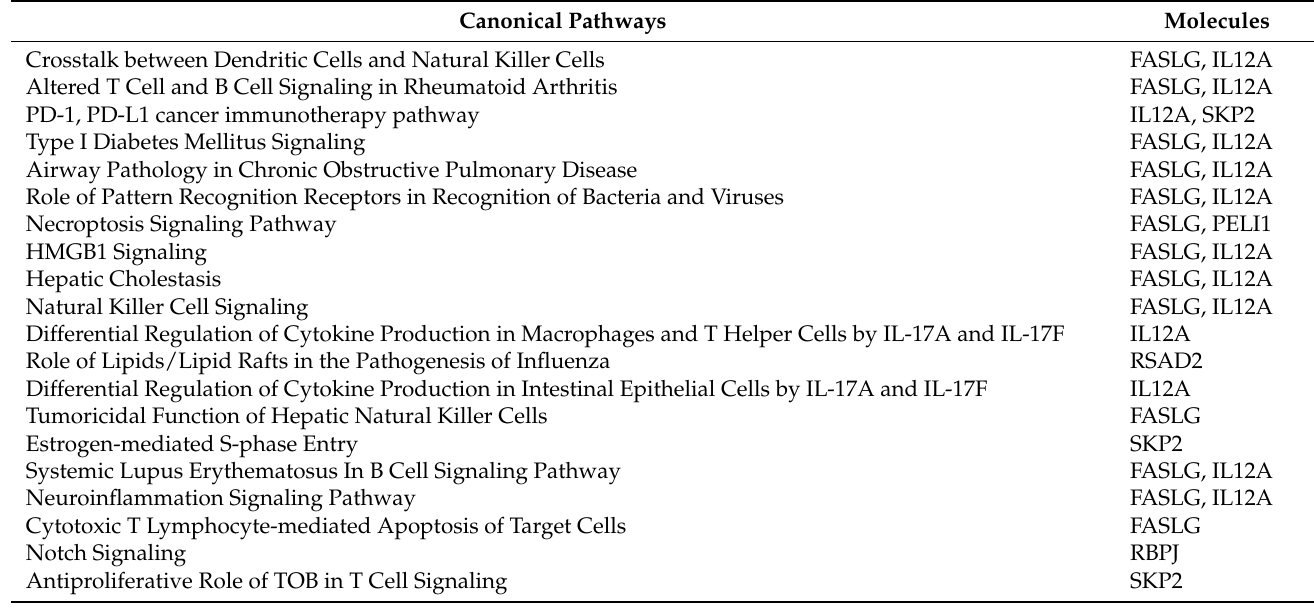
Table 4. Canonical pathways associated with top 20 hsa-miR-21-5p target genes. Canonical pathways identified via Ingenuity Pathway Analysis for the top 20 gene targets of hsa-miR-21-5p are reported. Canonical Pathways